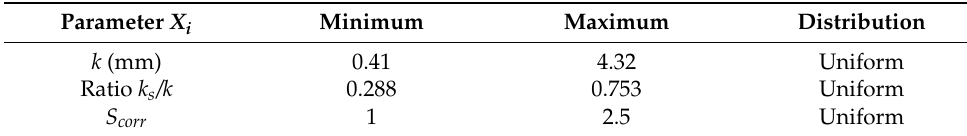
Table 1. Summary of the distributions for the input parameters.